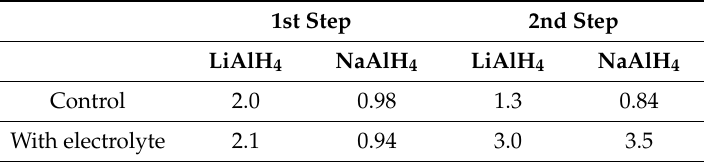
Table 5. Comparison of growth parameters determined from A-E fits to the first and second desorption steps for NaAlH 4 and LiAlH 4 with and without